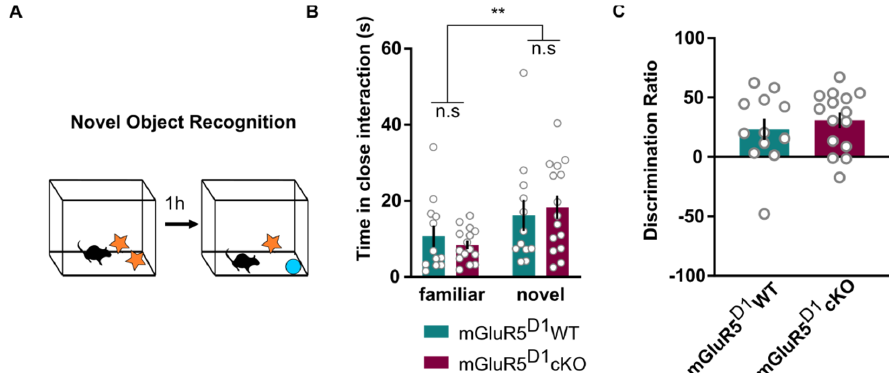
Figure 4. ( A ) Scheme of the novel object recognition behavioral paradigm. ( B ) mGluR5 D1 WT and cKO mice showed similar recognition memory as measured with time spent interacting with the objects (s): Two-way ANOVA, main effect genotype: F(1, 25) = 0.001, ns ( p = 0.97); main effect object: F(1, 25) = 11.41, p = 0.002; interaction effect: F(1, 25) = 0.94, ns ( p = 0.34). ( C ) mGluR5 D1 WT and cKO mice showed similar recognition memory, as measured with the discrimination ratio. Unpaired T-test, T = 0.69, ns ( p = 0.49). n = 12 mGluR5 D1 WT, n = 15 mGluR5 D1 cKO mice. ** p ≤